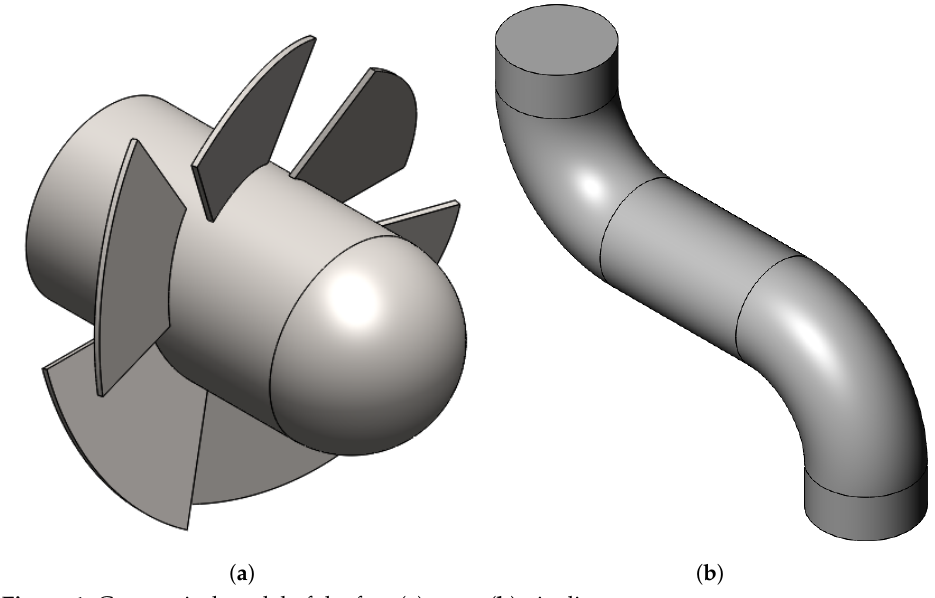
Figure 1. Geometrical model of the fan: ( a ) rotor, ( b ) pipeline.